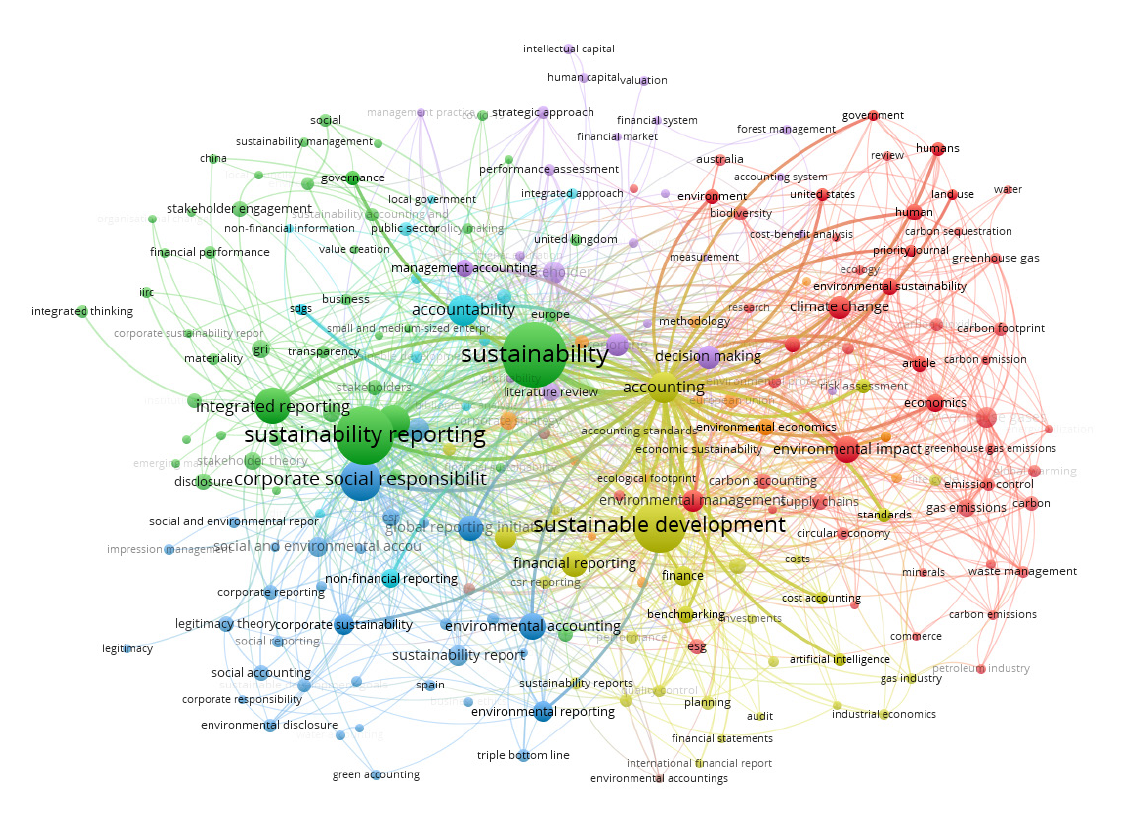
Figure 3. Defining the relationship between “sustainability reporting” and other concepts